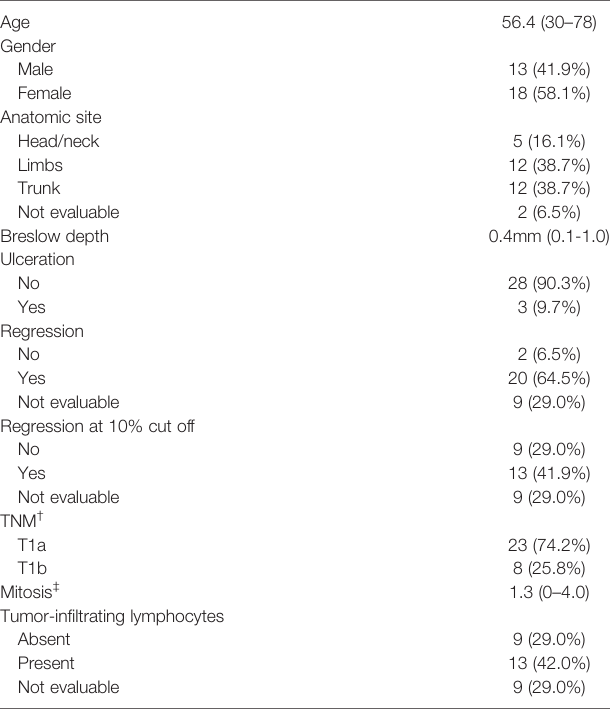
TABLE 1 | Patient and tumor